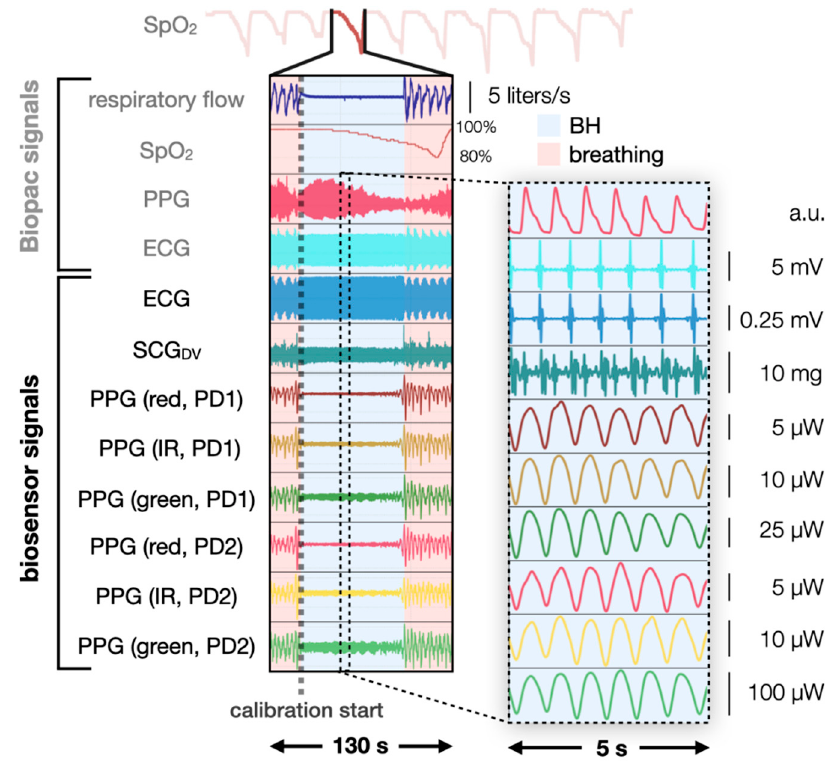
Figure 3. Biopac and biosensor signals during the fourth breath-hold (BH, blue) and during normal breathing (pink). A 5 s window during breath-hold is shown to illustrate the quality of the signals.